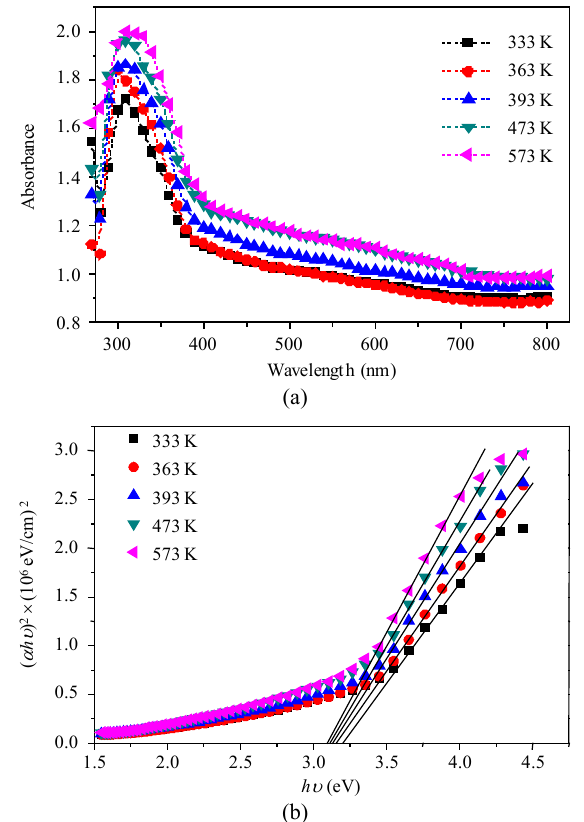
Fig. 3 Absorption spectra recorded from the TiO 2 films annealed at 333 K, 363 K, 393 K, 473 K, and 573 K (the dotted lines are visual guides) (a) and Tauc’s plots to the absorption spectra of the 333 K, 363 K, 393 K, 473 K, and 573 K annealed films